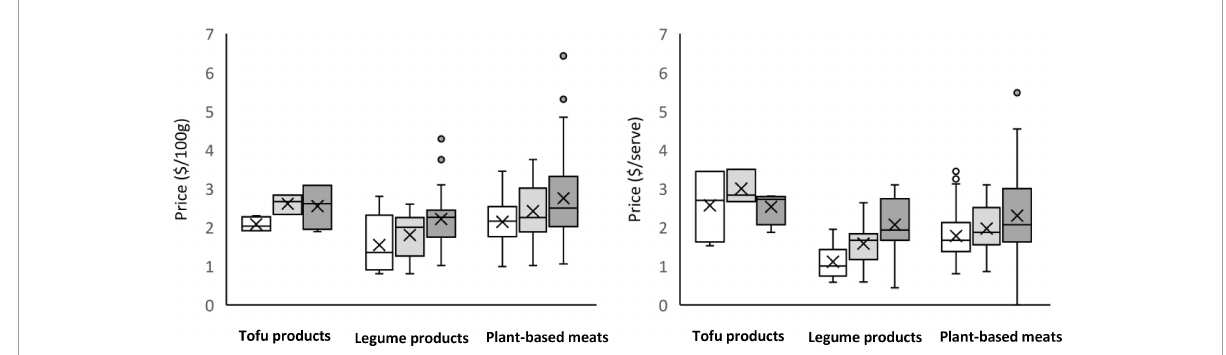
FIGURE4 Price of alternative protein products in 2014 (unshaded), 2017 (light shading) and 2021 (dark shading). (Left) Price per 100 g; (Right) price per serve. ALDI and IGA products included in the dataset from 2017. Prices are in AUD and are the regular sale price at the time of collection (i.e., not a promotional price). Price per serve was calculated based on manufacturers recommended serve size as listed on